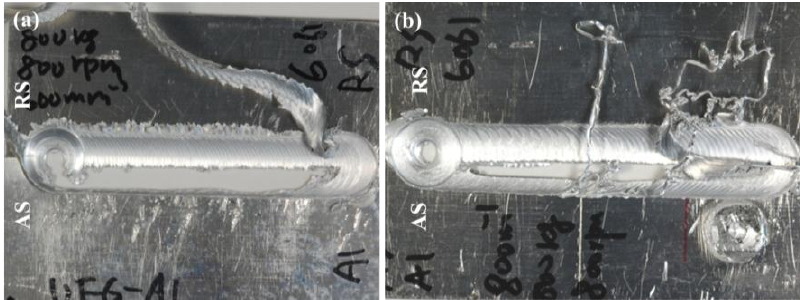
Figure 2. Photo showing the appearance of the dissimilar friction stir welding (FSW) joints with UFGed 1050Al on the advancing side (AS) and 6061-T6 on the retreating side (RS) produced at a revolutionary pitch of ( a ) 0.75 mm/rev; and ( b ) 1 mm/rev.